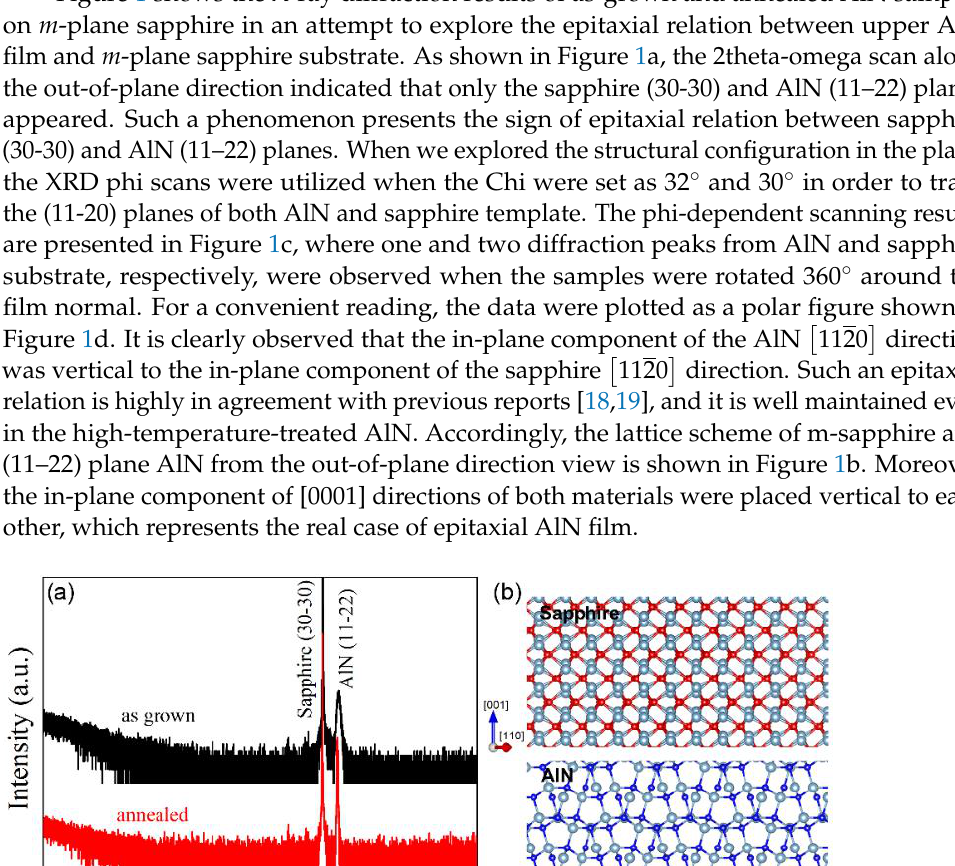
(cid:2) (cid:3) 1010 and